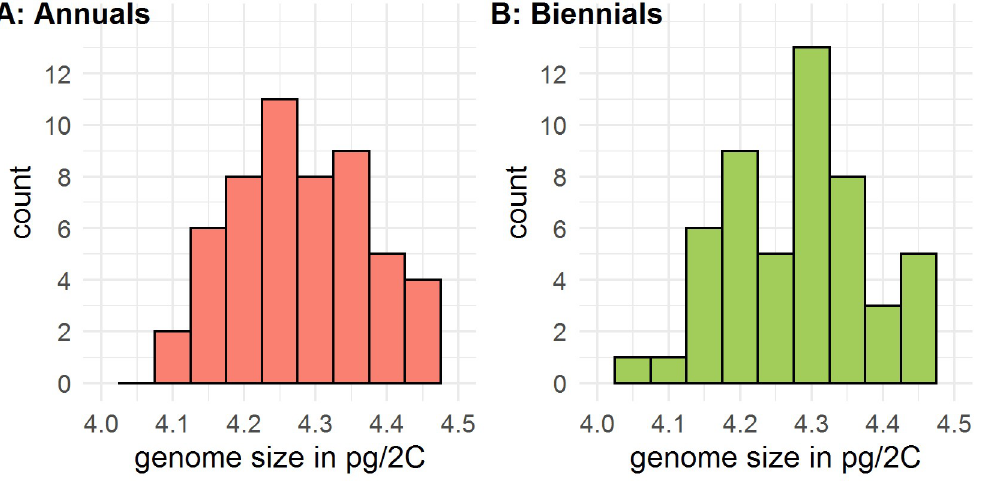
Fig 1. Estimated genome size (in pg/2C) of caraway based on flow cytometric analysis of 35 accessions. Three biological replicates per accession were investigated.